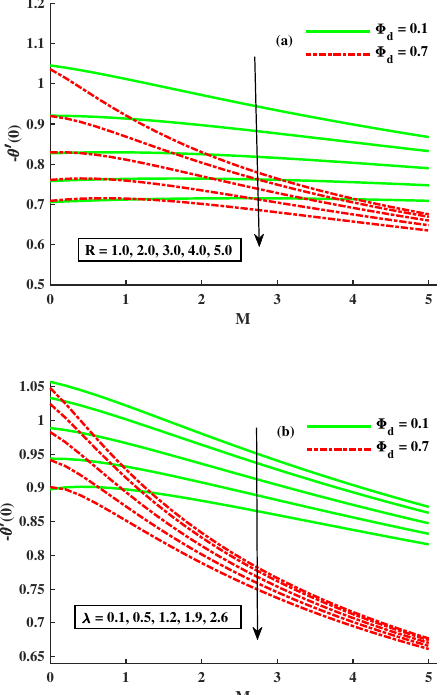
( 0 ) & ( b ) H (cid:48) ( 0 ) . 2 1